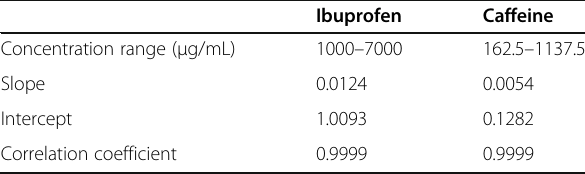
Table 2 Linear regression data for calibration